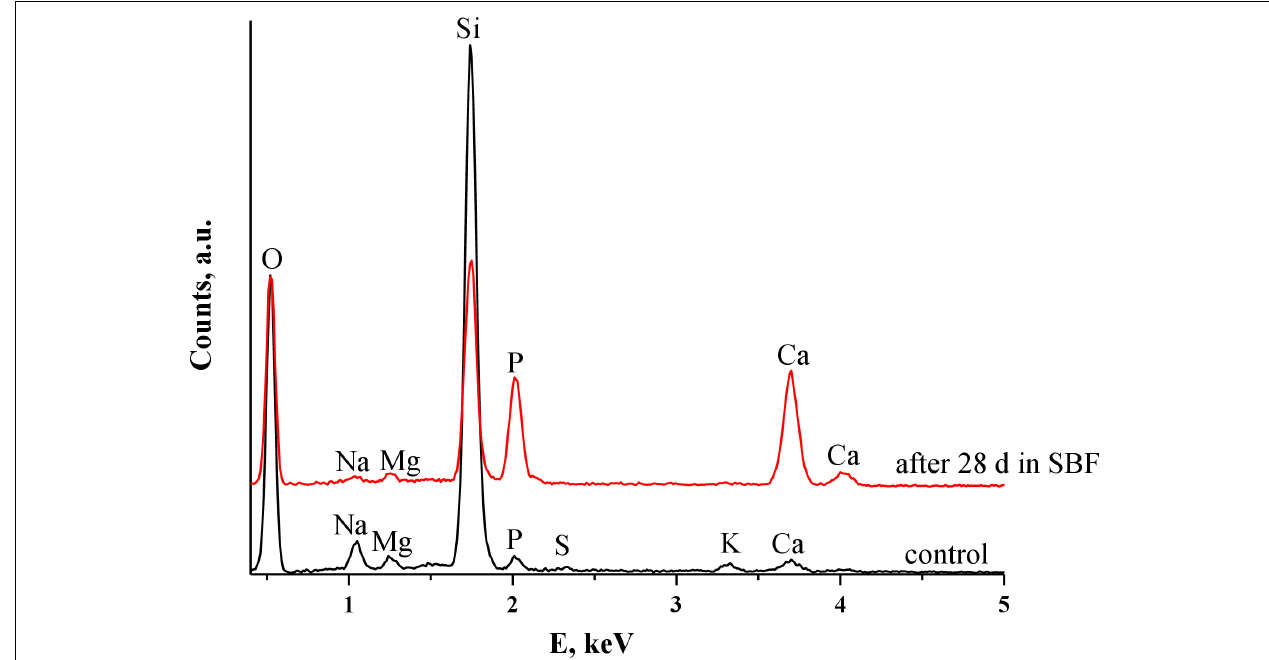
FIGURE 6 | EDS spectra of GA-derived biosilica before and after immersion in SBF (for 28